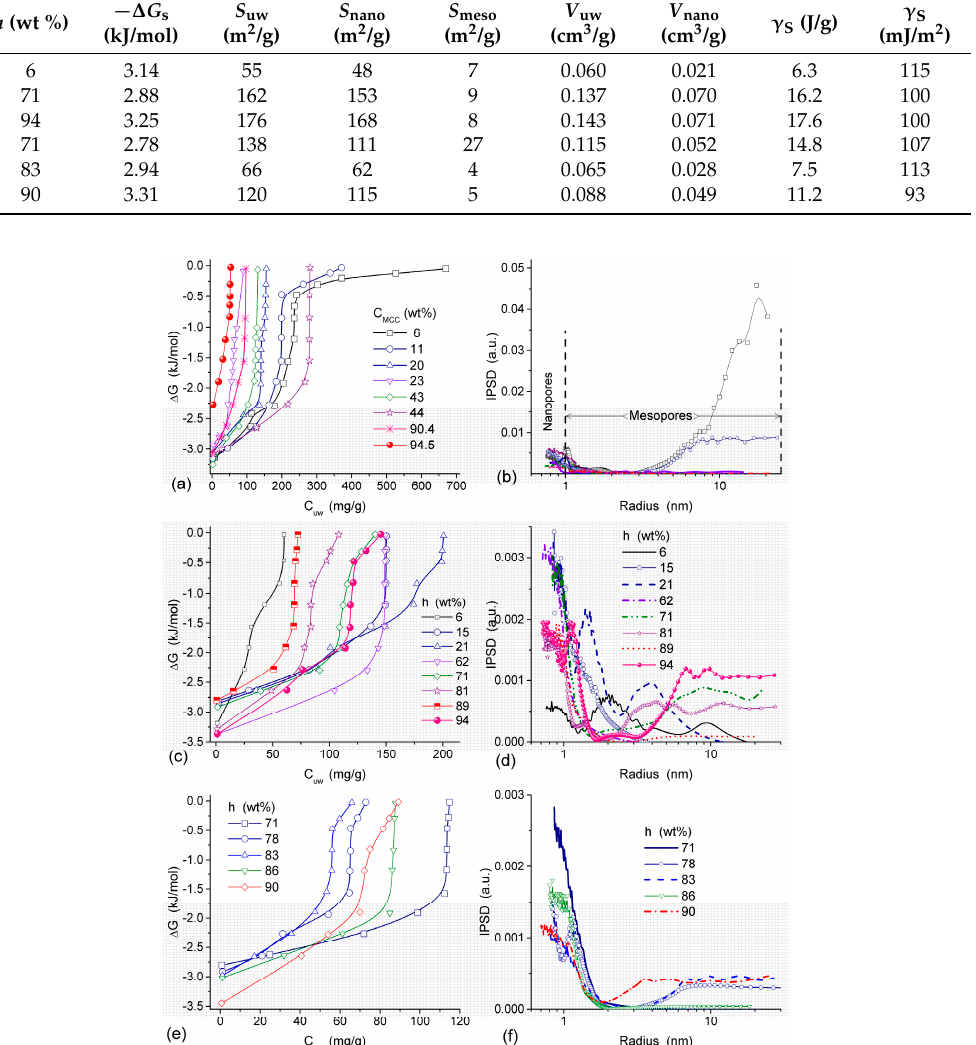
Figure 19. PSD ( k GT = 70 K nm) for A-300/PVP systems (adapted from [13]).